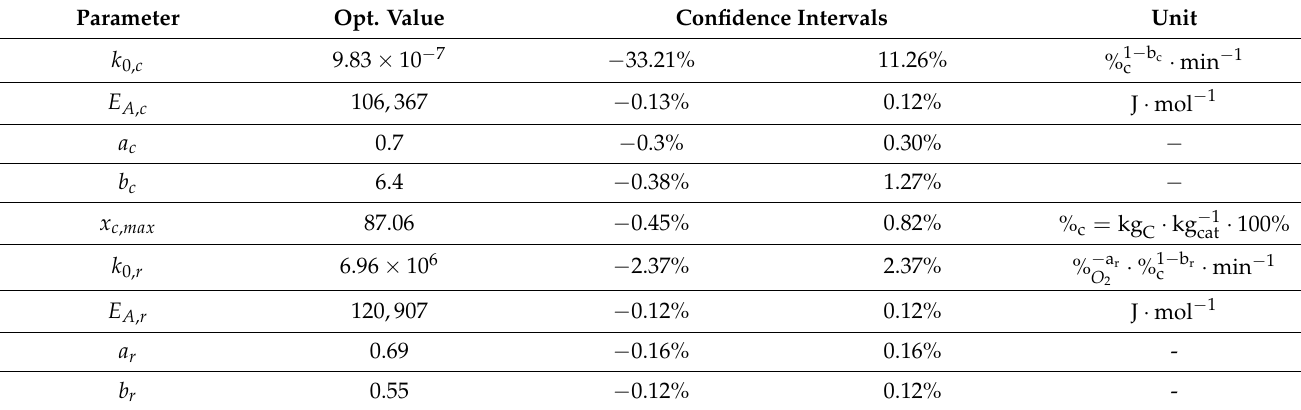
Table 3. Optimized kinetic parameters of the coke growth and the coke burning/catalyst regeneration. Parameter Opt. Value Confidence Intervals Unit